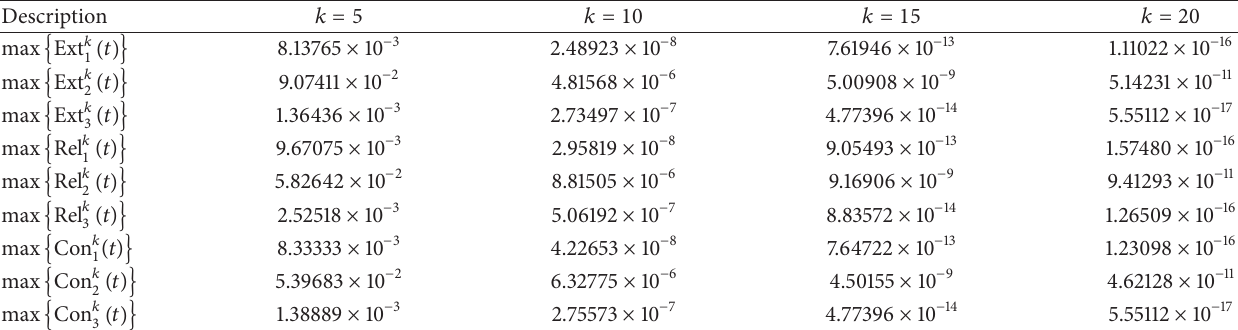
Table 3: Maximum error functions of 𝑥 𝑘 𝑖 (𝑡) , 𝑖 = 1 , 2, 3, for 𝑘 = 5 , 10, 15, and 20 in [0, 1] .